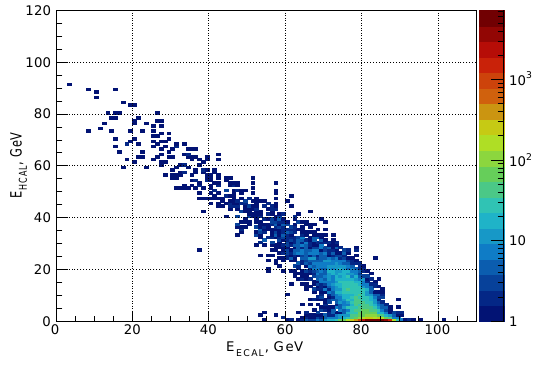
Figure 2. Two-dimensional distribution of the events in the physical run after the tracker and veto cuts.